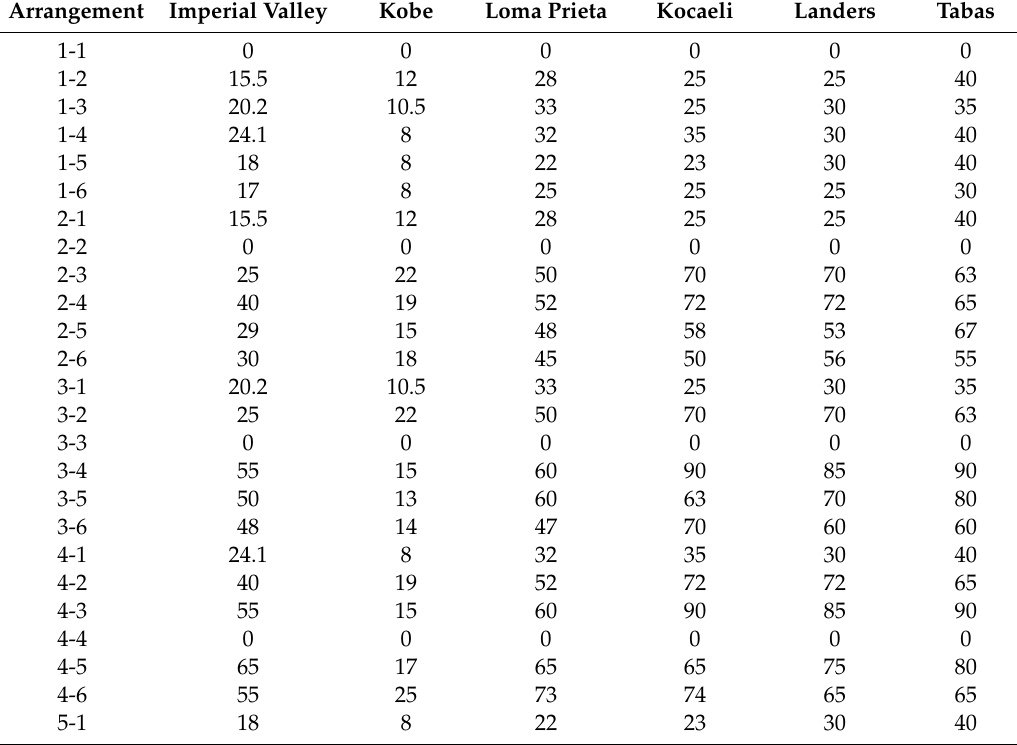
Table 3. Required seismic gap obtained from the analysis using ANN (cm).